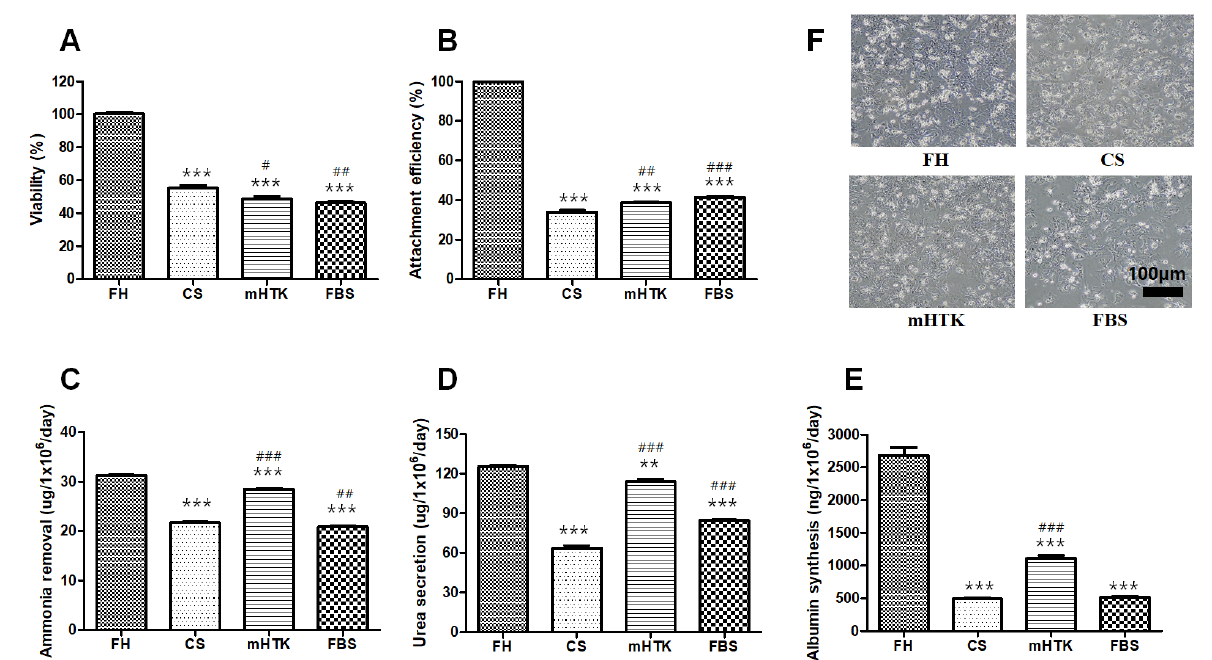
Figure 2. Effect of cryopreservation solutions on porcine hepatocytes viability and liver ‐ specific func ‐ tions in post ‐ thaw cultures. Porcine hepatocytes were cryopreserved in three different freezing solu ‐ tions containing 15% DMSO and stored for 1 month in liquid nitrogen. The hepatocytes were thawed by rapid warming in a water bath and washed twice in thawing medium (first, the cells were rapidly suspended in a warm medium with 10% FBS, and then the medium was replaced with a warm HDM). ( A ) Cell viability, ( B ) attachment efficiency (assessed using a 3 ‐ (4,5 ‐ dimethyl thiazol ‐ 2 ‐ yl) ‐ 2,5 ‐ diphe ‐ nyltetrazolium bromide assay), ( C ) ammonia removal, ( D ) urea secretion, and ( E ) albumin synthesis were evaluated after thawing and plating for 24 h. Representative images of ( F ) porcine hepatocytes showing their morphology after plating and maintenance in culture for 24 h (×100). Fresh primary hepatocytes (upper left, FH) and hepatocytes cryopreserved using CryoStor CS10 (upper right, CS), modified HTK + DMSO (lower left, mHTK), and fetal bovine serum + DMSO (lower right, FBS). Sta ‐ tistical significance compared to fresh primary hepatocytes (FH): * p < 0.05, ** p < 0.01, *** p < 0.001, and compared to the control freezing solution (CS): # p < 0.05, ## p < 0.01, ### p < 0.001.